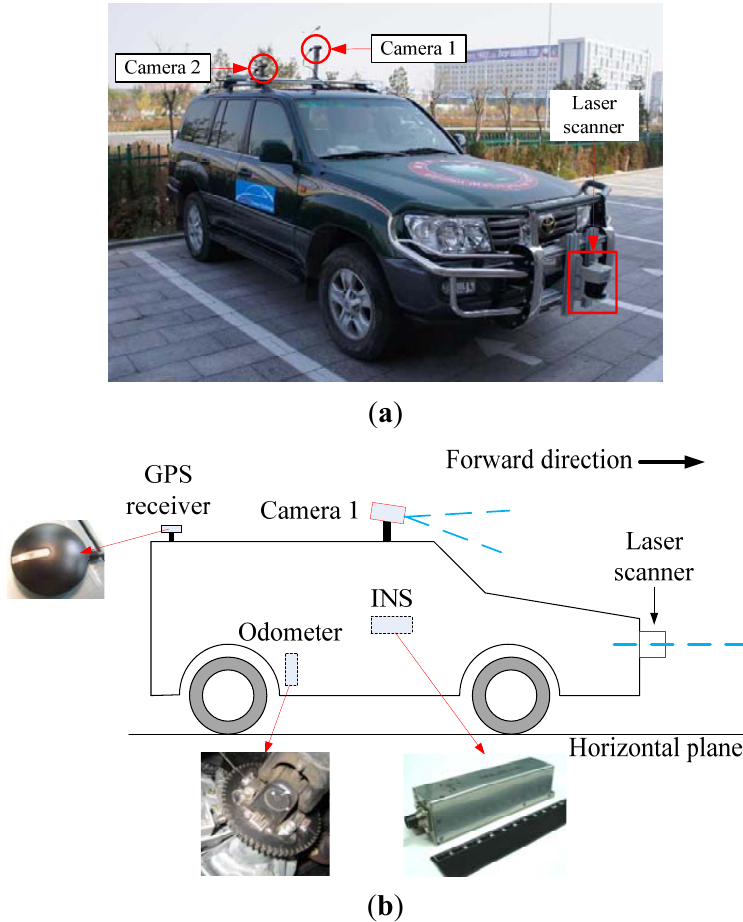
Figure 8. The Beijing Institute of Technology Unmanned Ground Vehicle. ( a ) BITUGV and its environment sensors, including one laser sensor and two cameras. ( b ) Side view of the BITUGV and its localization equipment, including a global positioning system (GPS) receiver, an odometer and an inertial navigation system